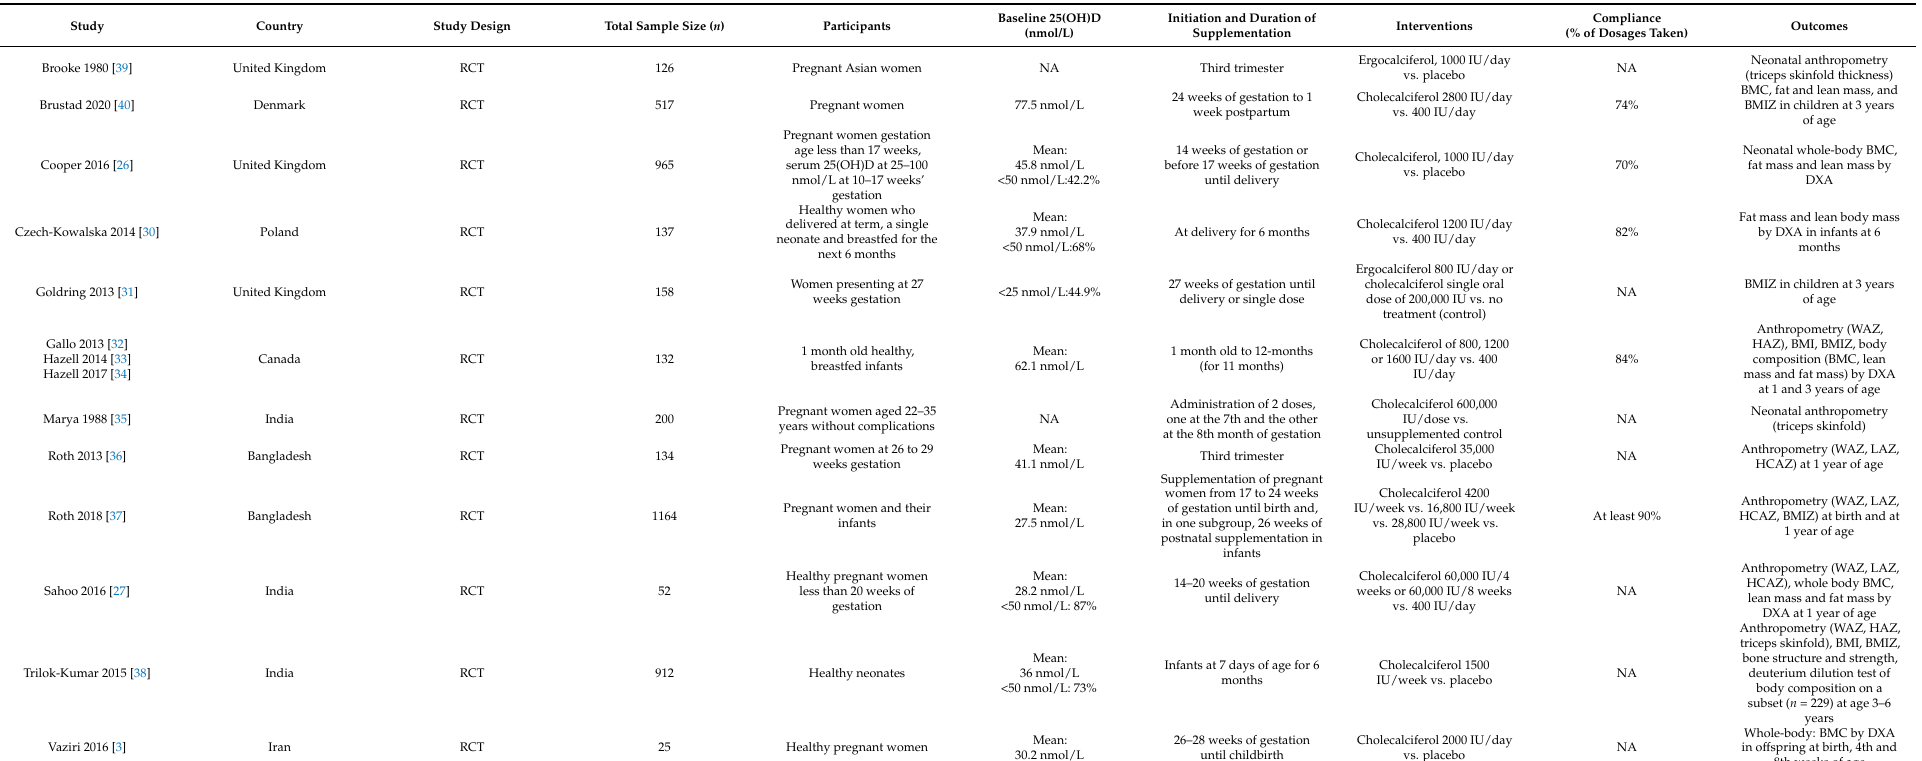
Table 1. Characteristics of the included studies 1